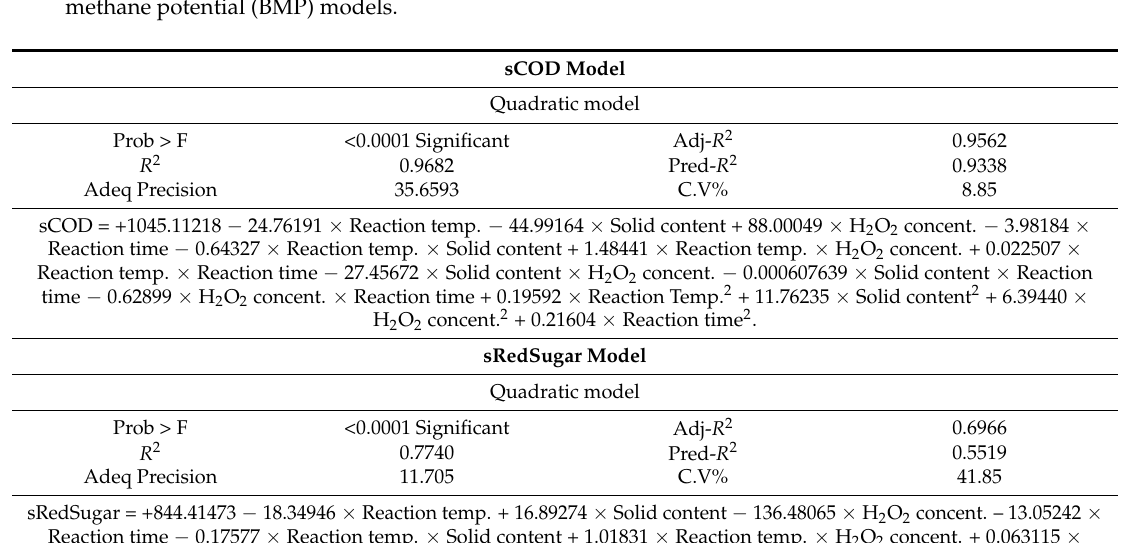
Table 2. ANOVA results for sCOD, sRedSugar, total lignin on an extractives free bases, and biochemical methane potential (BMP)